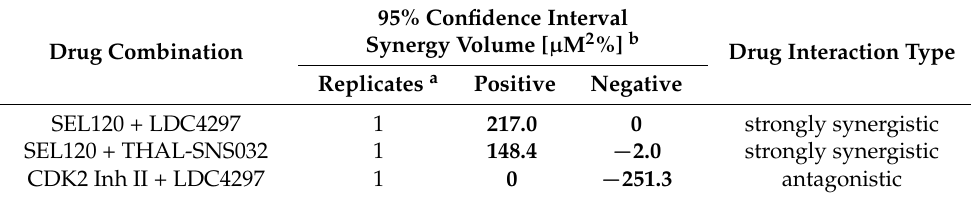
Figure 1. Depiction of two synergistic interactions between host-directed PKIs, evaluated via Bliss independence checkerboard assay (left) and Loewe additivity fixed-dose assay (right): ( A ) SEL120 + LDC4297, ( B ) SEL120 + THAL-SNS032. The inserted tables shaded in grey give the sum of positive and negative 95% confidence interval synergy volumes (SV) [ µ M 2 %], as well as weighted combination index values (CI wt ) for these two drug combinations (see Tables 3 and 4 for detailed results). Table 3. Combinatorial anti-HCMV drug assessment using the Bliss independence checkerboard